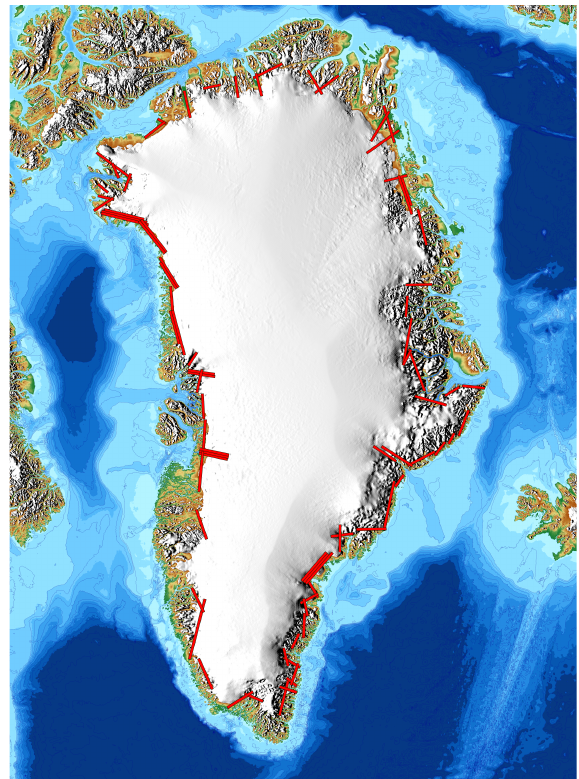
Figure 5. Map showing the locations of yearly GLISTIN-A data collection for